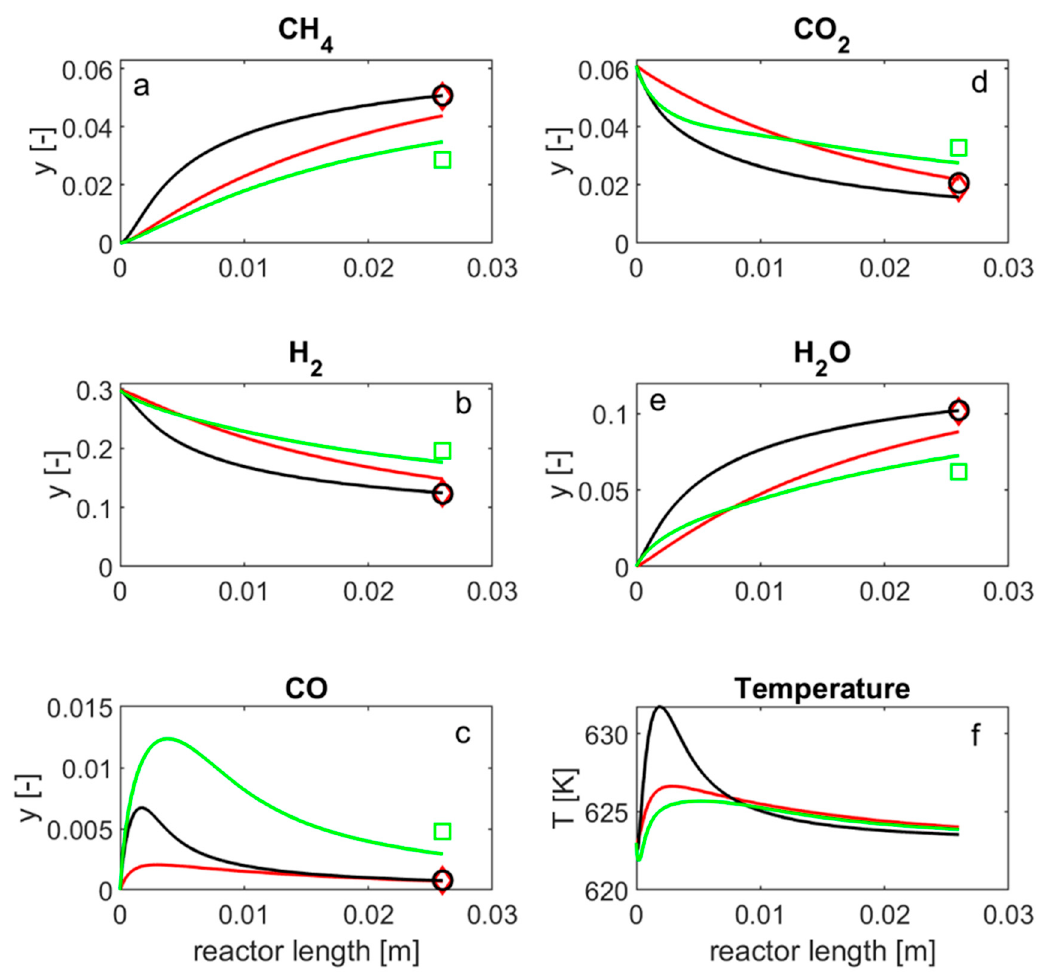
Figure 3. Results for the MCO2 operating mode (gas hourly space velocity (GHSV) = 6.7 × 10 3 h − 1 ), furnace temperature 623 K. ( a ) CH 4 ; ( b ) H 2 ; ( c ) CO; ( d ) CO 2 ; ( e )H 2 O; and ( f ) temperature. Simulation results are reported only for the catalytic section (PBR) of the reactor. Lines: simulations. Symbols: experimental data (at the sampling point). Catalysts: